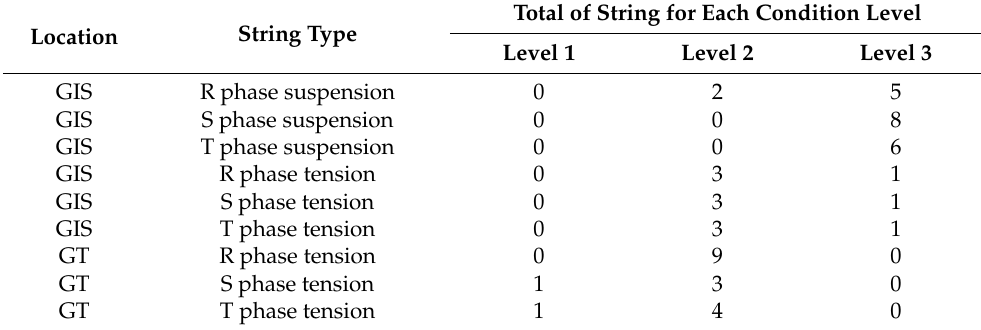
Table 5. Visual-based assessment results for all insulator strings at the GIS and GT